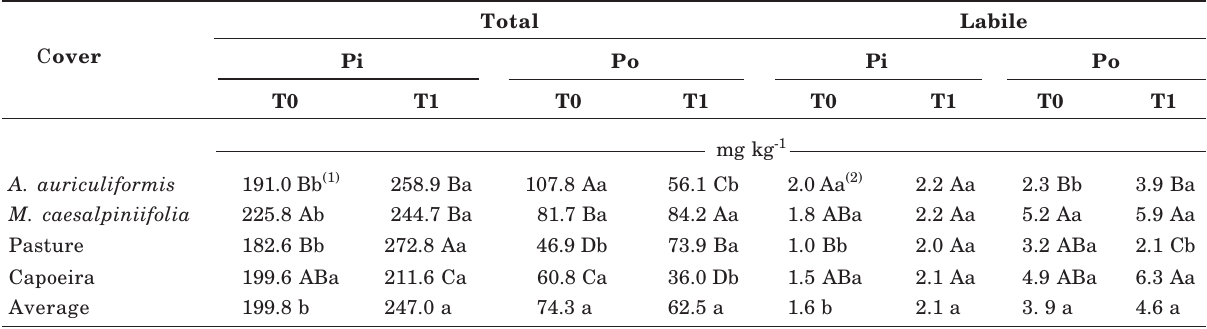
(1) For Total P forms, averages followed by the same uppercase letters in the column (comparing covers in each incubation time) and averages followed by the same lowercase letters in the row (comparing each cover at different times) are not significantly different by Tukey’s test at 5 %. (2) For Labile P forms, averages followed by the same uppercase letters in the column (comparing covers in each incubation time) and averages followed by the same lowercase letters in the row (comparing each cover at different times) are not significantly different by Tukey’s test at 5 %.